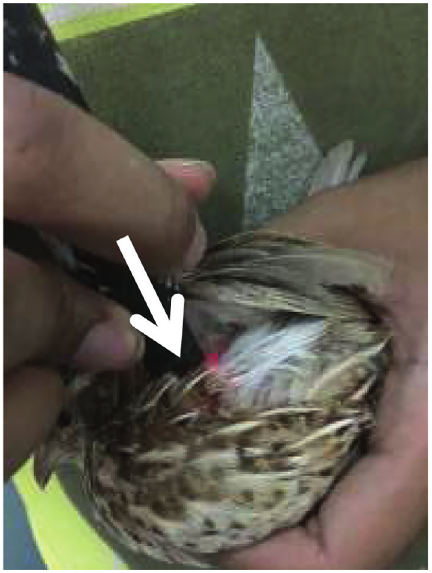
Figure 3: Laser puncture shooting at the Bei Ji point.